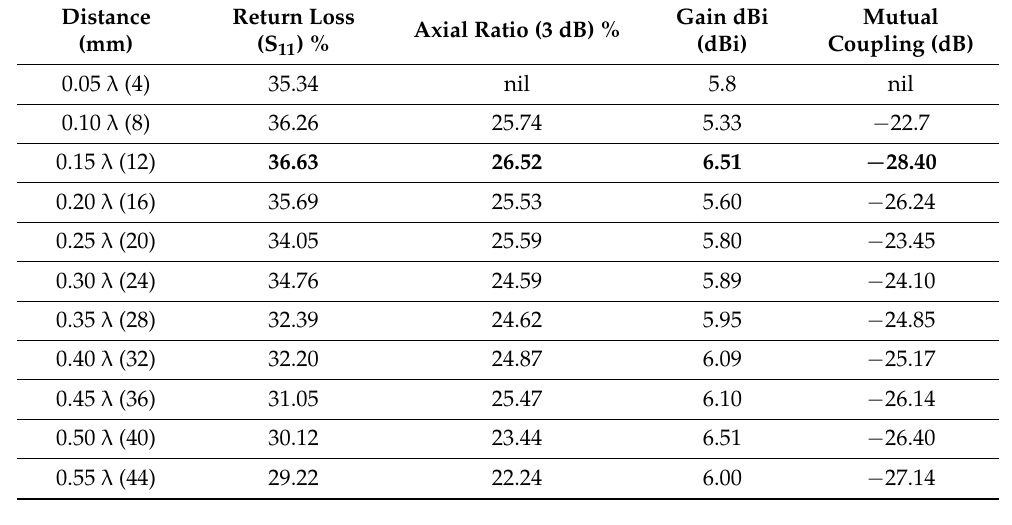
Table 4. S11, AR bandwidth, gain, and isolation at different spacings.